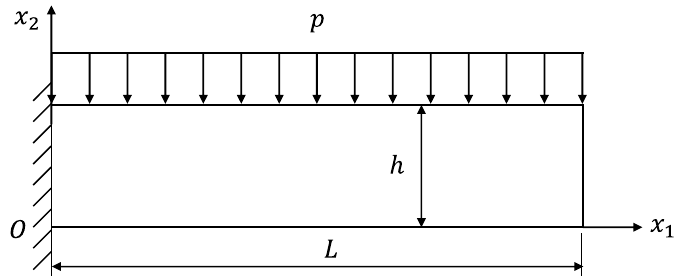
Figure 8. Cantilever beam constrained with a distributed load.